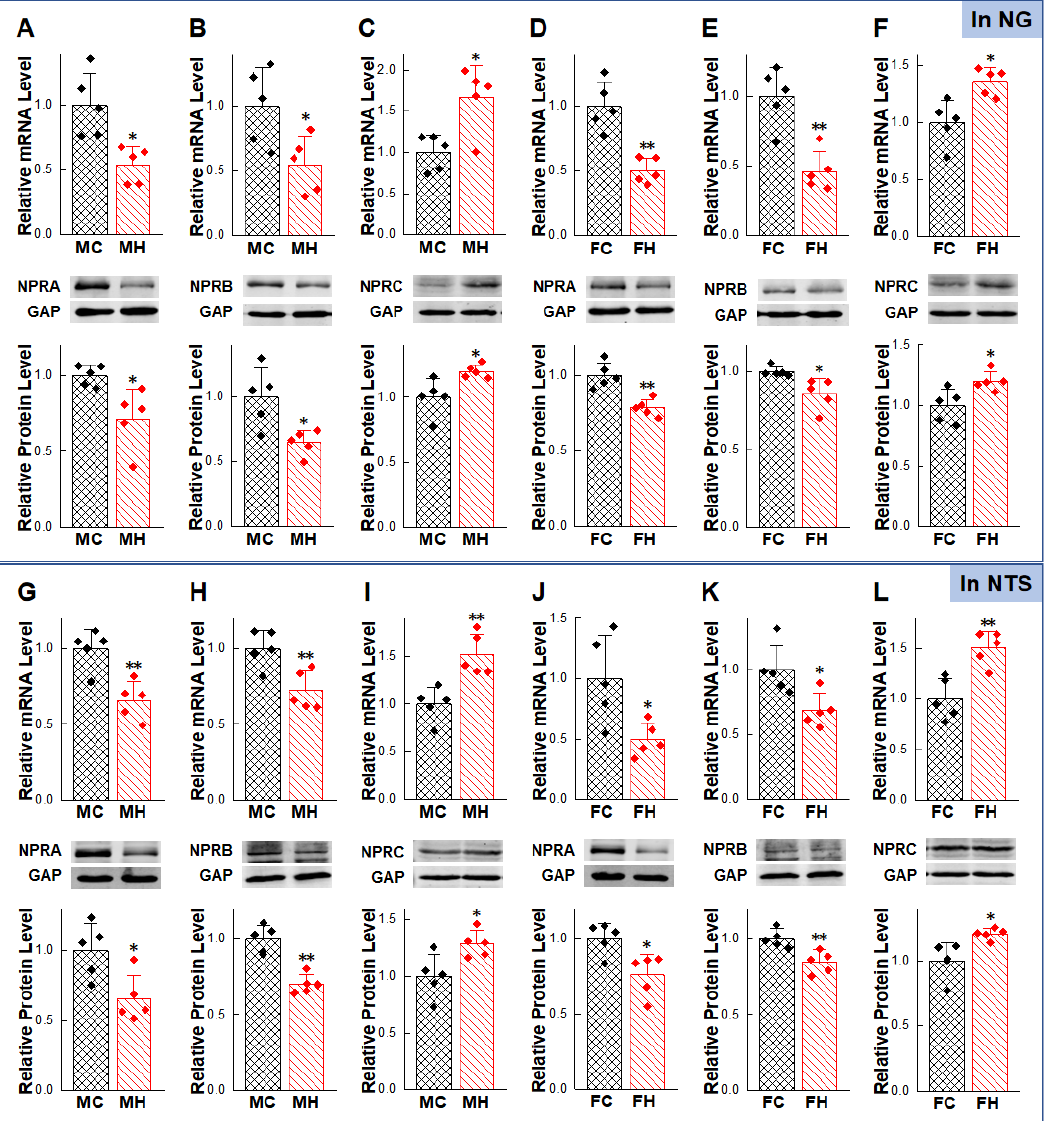
Figure 5. Abnormal expression of natriuretic peptides receptors (NPRs) in nodose ganglion (NG) and nucleus tractus solitarius (NTS) under hypertensive condition. Expression changes in NPRs were verified in NG ( A – F ) and NTS ( G – L ) of high-fructose-drinking-induced hypertension (HFD) models of adult male and female rats. Averaged data was presented as mean ± SD. GAPDH means the internal control. * p < 0.05, ** p < 0.01 vs. male or female control rats, n = 5.